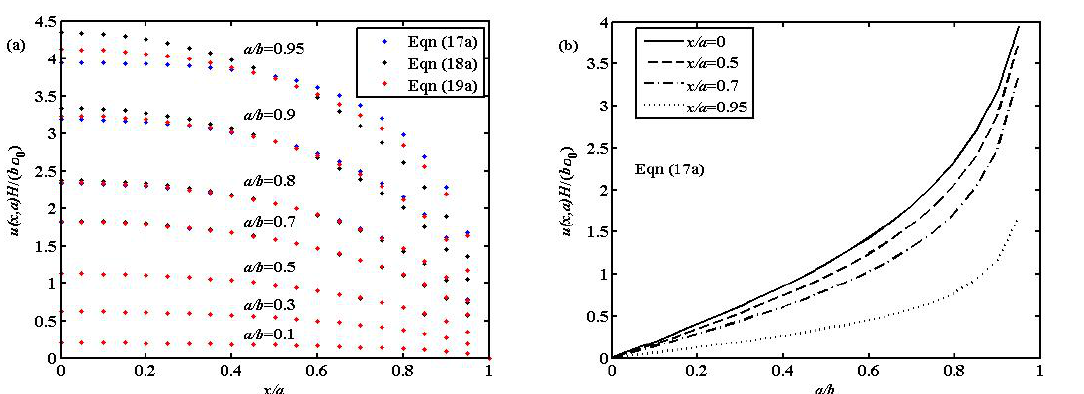
Figure1: Comparisons of the dimensionless crack face displacements for collinear cracks (a) Hu ( x , a )/( σ 0 b) versus x / a ; (b) Hu ( x , a )/( σ 0 b) versus a / b